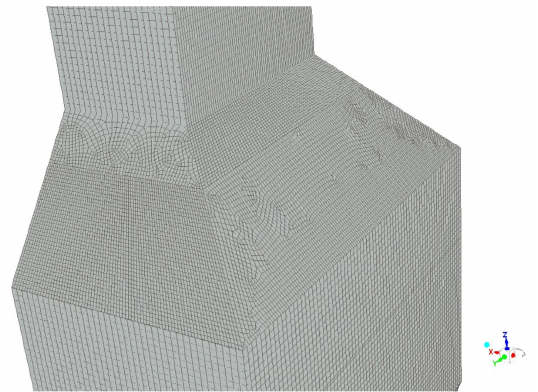
Figure 2. Meshing geometry of the representative area.